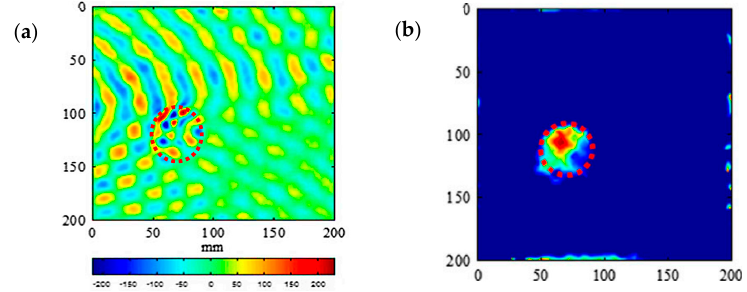
Figure 20. Comparisons of two snapshots of a composite plate with delamination defect under inspection with guided wave method (marked with a dashed red circle); ( a ) time domain out-of-plane displacement response of a composite plate and ( b ) frequency-wavenumber visualization of defect [141].